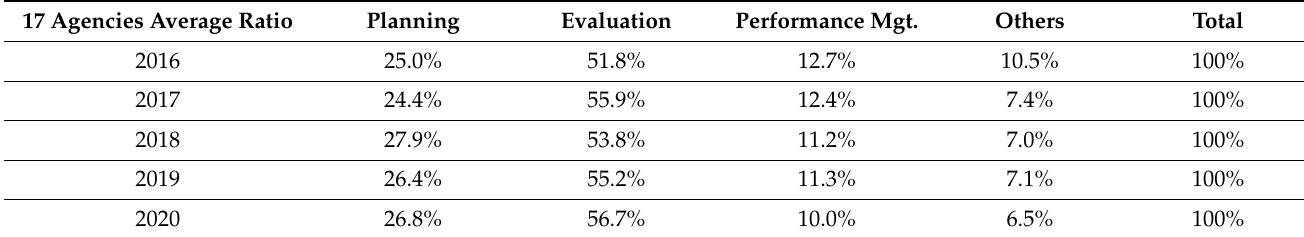
Table 4. Average ratio of major R&D planning and evaluation costs by purpose of use (2016–2020). (Unit: %). 17 Agencies Average